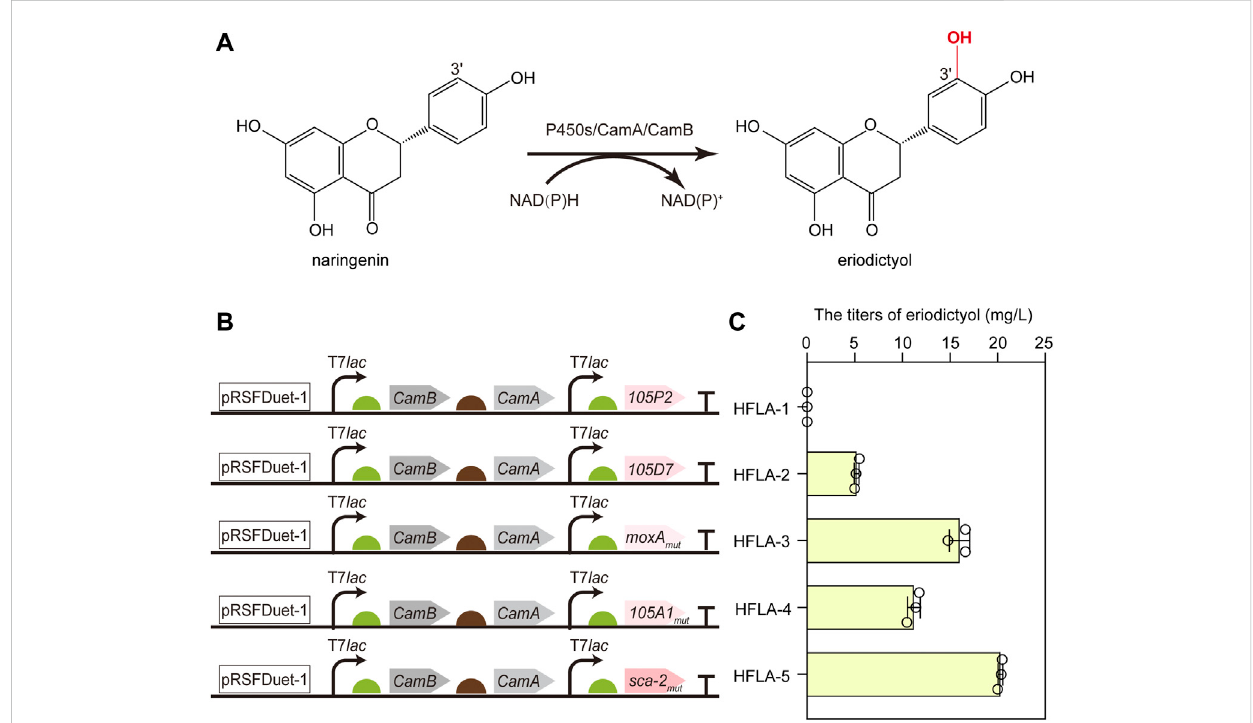
Screening of the ef fi cient bacterial P450s for the hydroxylation of fl avonoids. (A) Schematic representation of the regioselective hydroxylation of naringenin by P450s with redox partners of CamA and CamB. (B) Schematic diagram of combining different P450s and redox partners to construct whole-cell biocatalyst plasmids. P450s included CYP105P2, CYP105D7, P450 moxA mut , CYP105A1 mut , and P450 sca-2 mut . (C) Titers of eriodictyol produced by whole-cell biocatalysts of different P450s using 100 mg/L naringenin. The data are shown as mean ± SD of three biological